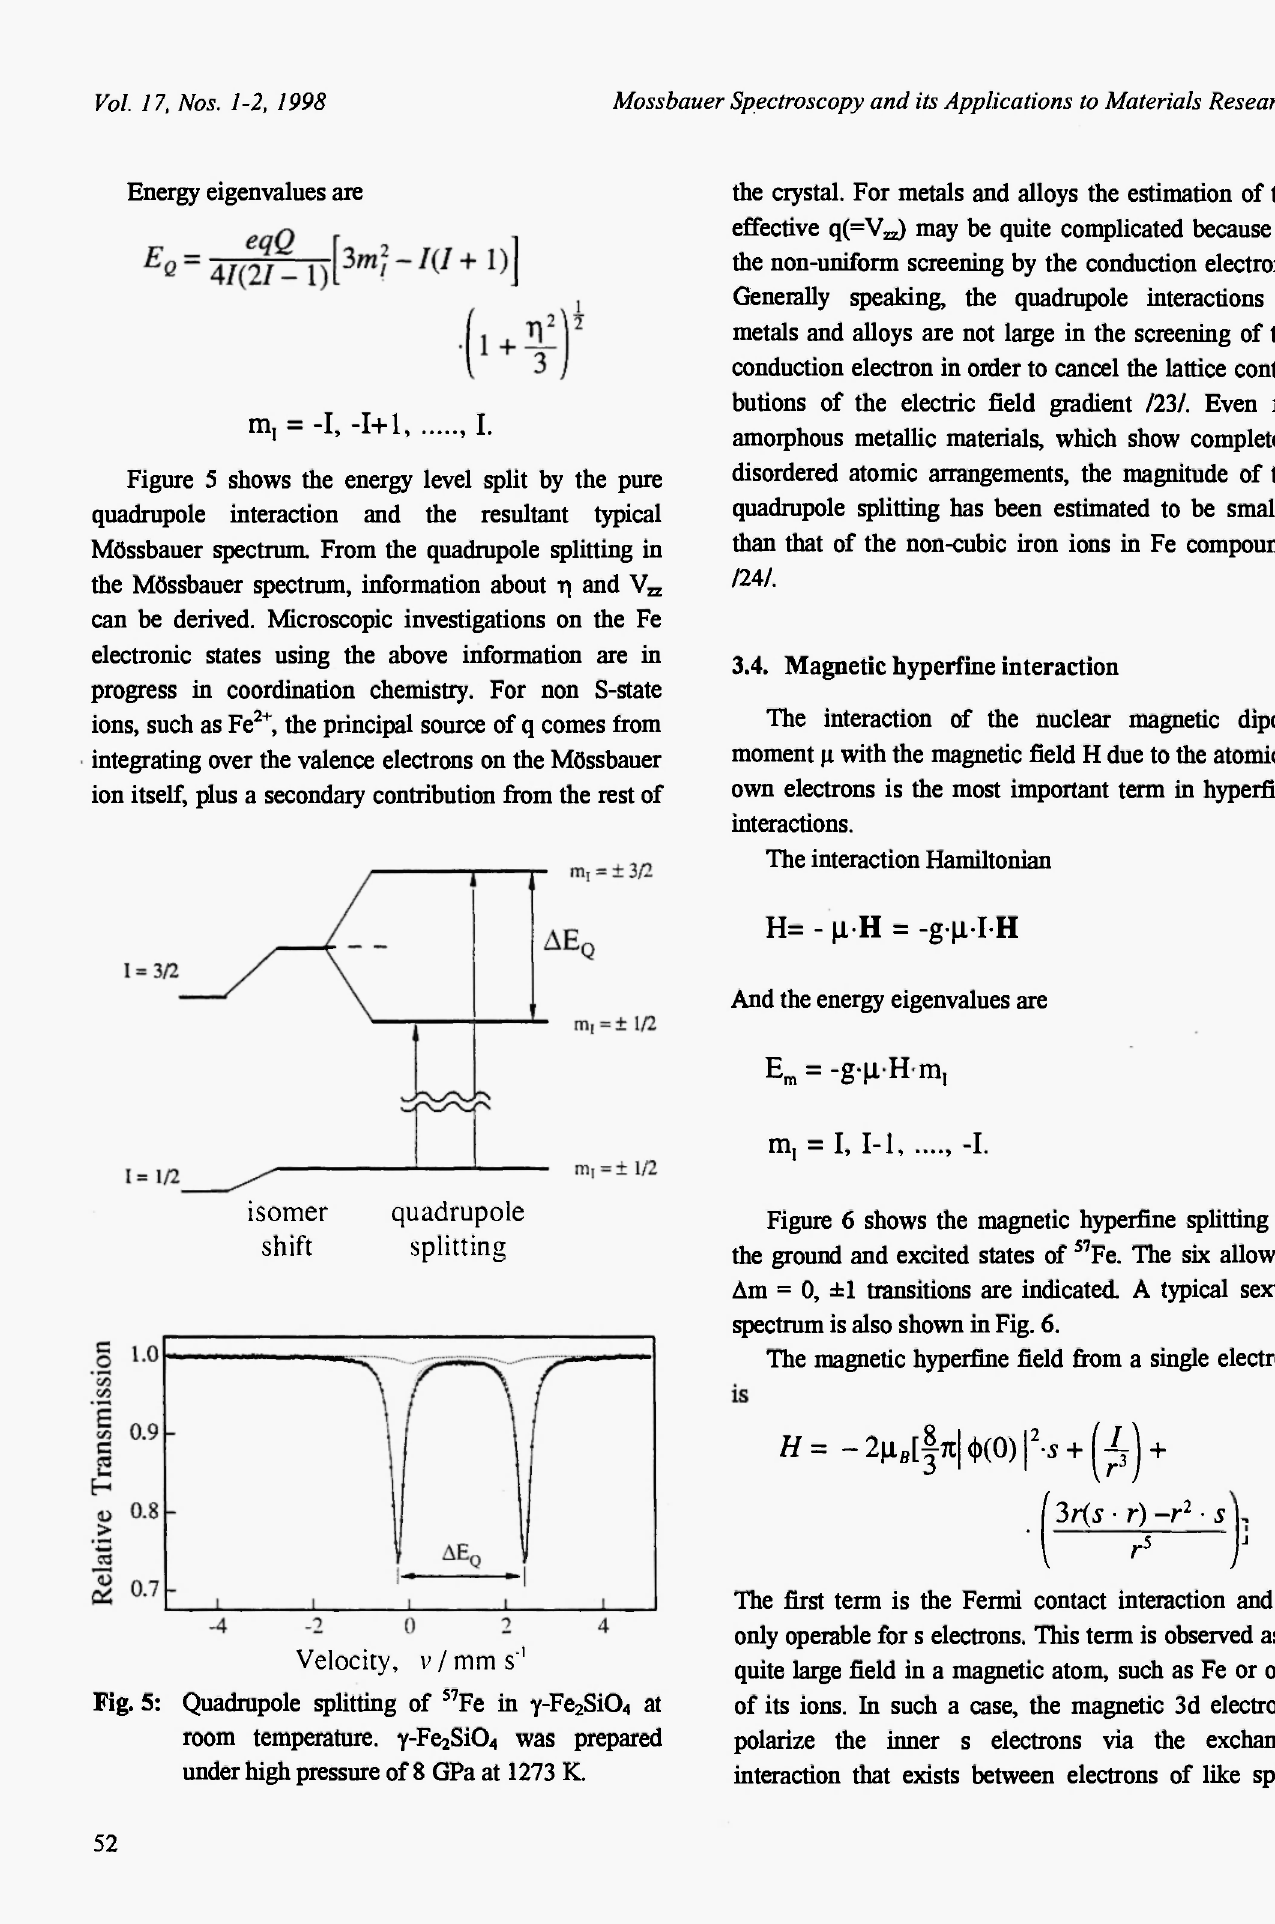
Fig. 5: Quadrupole splitting of 57 Fe in y-Fe room temperature. y-Fe2Si0 under high pressure of 8 GPa at 1273